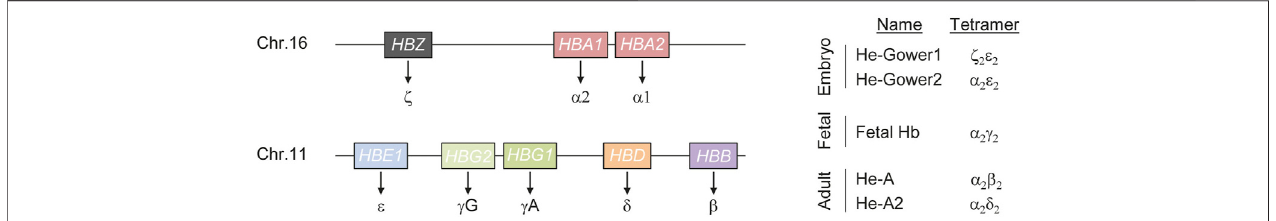
FIGURE 1 | Schematics of human hemoglobin. Hemoglobin (He) is a tetrameric protein composed of two alpha and two non-alpha chains. Three genes ( HBS , HBA1 and HBA2 ) encode for the alpha chains while fi ve genes ( HBE1 , HBG1 , HBG2 , HBD and HBB ) result in non-alpha chains synthesis (left). Fine tuned regulation of these genes during development results in the formation of hemoglobin tetramers of different composition